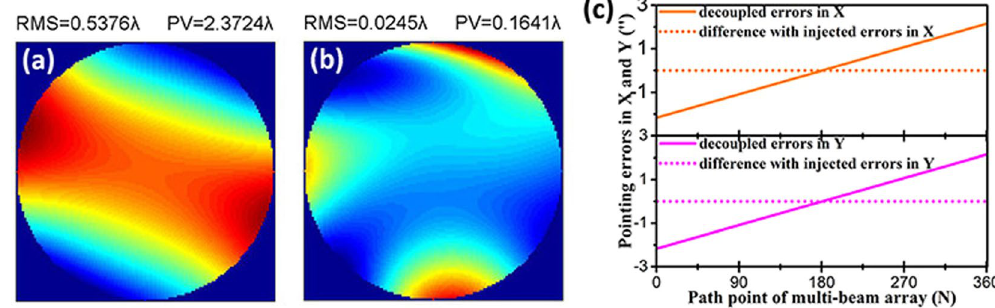
Figure 5. ( a ) WFE map for the simulated test with 0 to 4.3 seconds of arc ( ″ ) linear pointing errors, ( b ) WFE map for the simulated test with 0 ″ to 4.3 ″ linear pointing errors after correction by the stitching algorithm, ( c ) pointing errors decoupled from measured